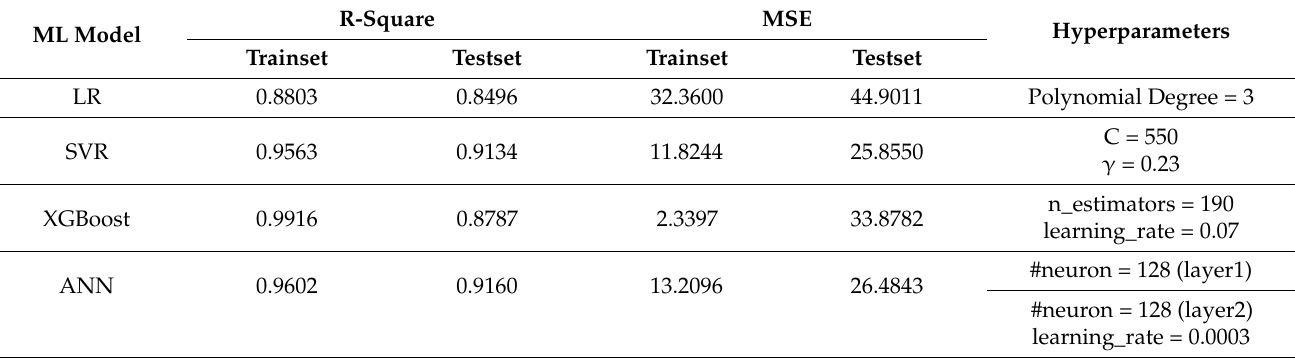
Table 4. Prediction results with 6 PCA-selected features.